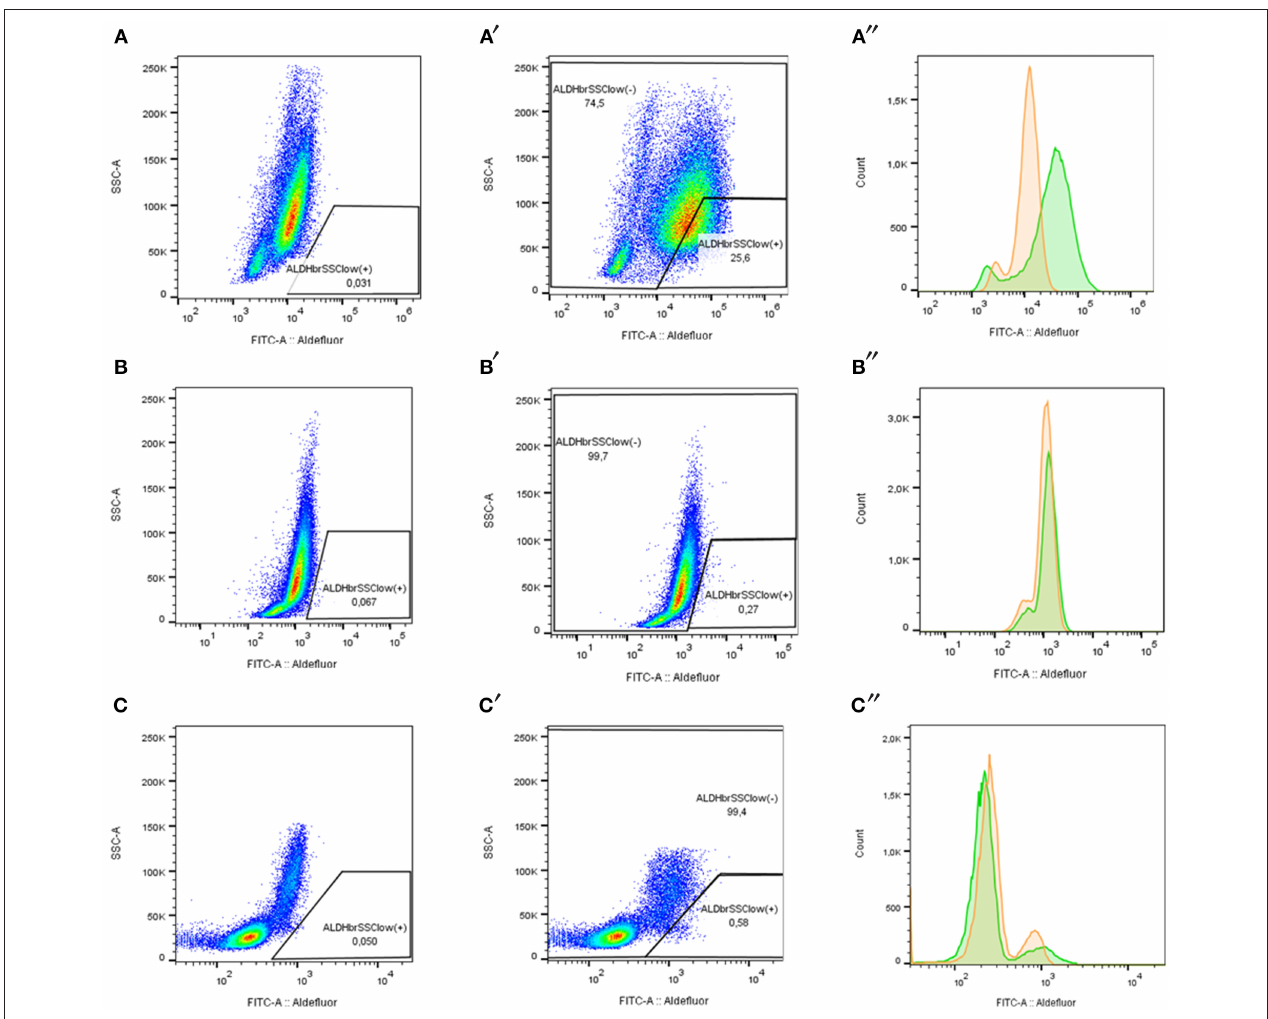
FIGURE 6 | ALDH pattern determination according to ALDH expression in acute leukemia samples stained with ALDEFLUOR reagent. (A–C) ALDH bright SSC low ( + ) cells percentage with Aldefluor inhibitor (DEAB + ). (A ′ -C ′′ ) . ALDH bright SSC low ( + ) cells and ALDH bright SSC low (-) cell percentage without inhibitor (DEAB-). (A ′′ -C ′′ ) FITC fluorescence distribution determines ALDH activity in human samples. DEAB + (orange) and DEAB- (green). (A–A ′′ ) LPZ6 (ALDH-numerous). (B–B ′′ ) LPZ12 (ALDH-rare). (C–C ′′ ) Non-leukemic cells from a healthy donor (negative